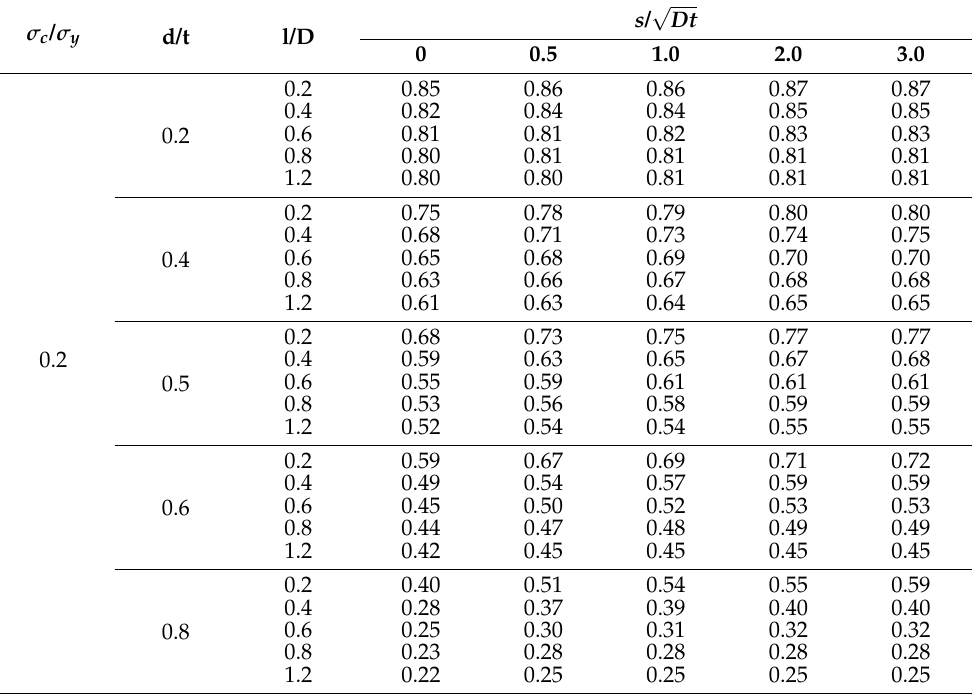
Figure 11. The interaction limit for the API 5L X65 pipeline with longitudinal interacting √ Dt , consistent with DNV. defects is therefore 2.0 s / Table 6. FEA on corroded pipeline with LID subjected to internal pressure and 0.2 σ c / σ y longitudinal compressive stress.